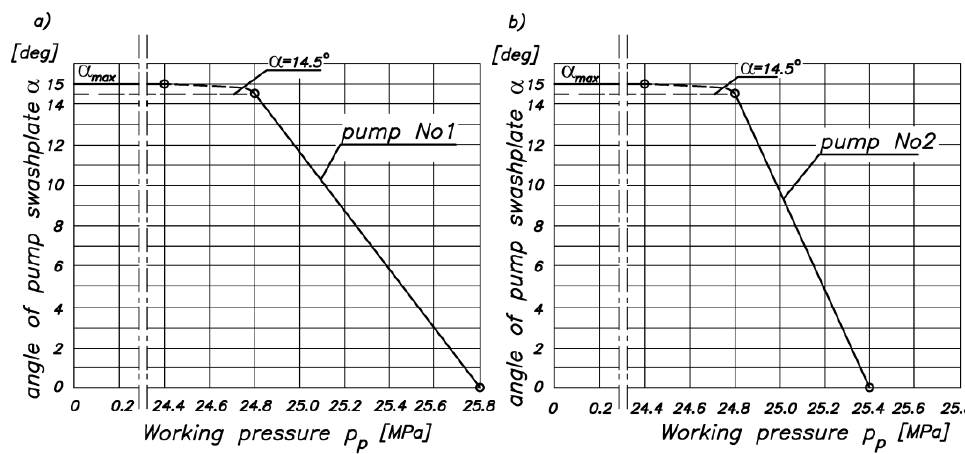
Figure 3. ( a , b ) Linear control characteristics of the DP-type constant-pressure pump regulator for both positive displacement pumps. Source: own preparation.